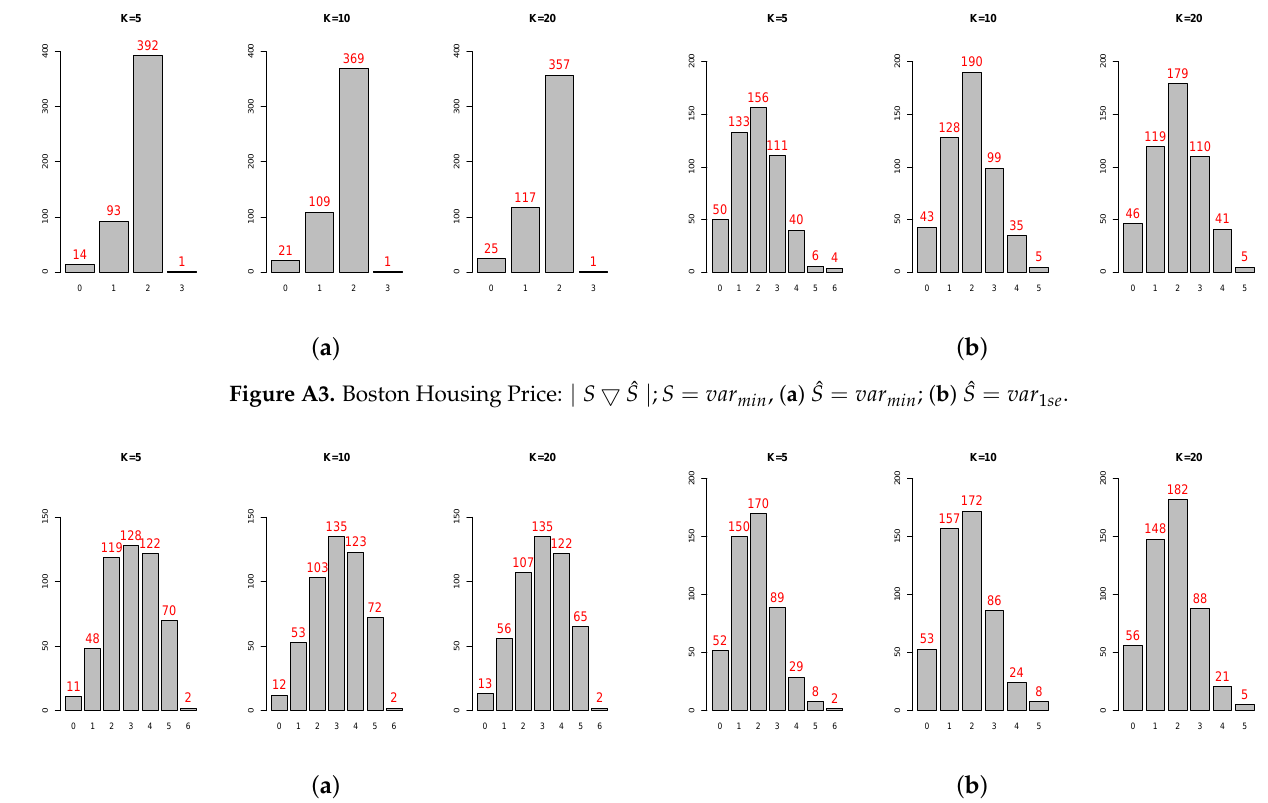
Figure A4. Boston Housing Price: | S (cid:53) ˆ S | ; S = var 1 se , ( a ) ˆ S = var min ; ( b ) ˆ S = var 1 se .